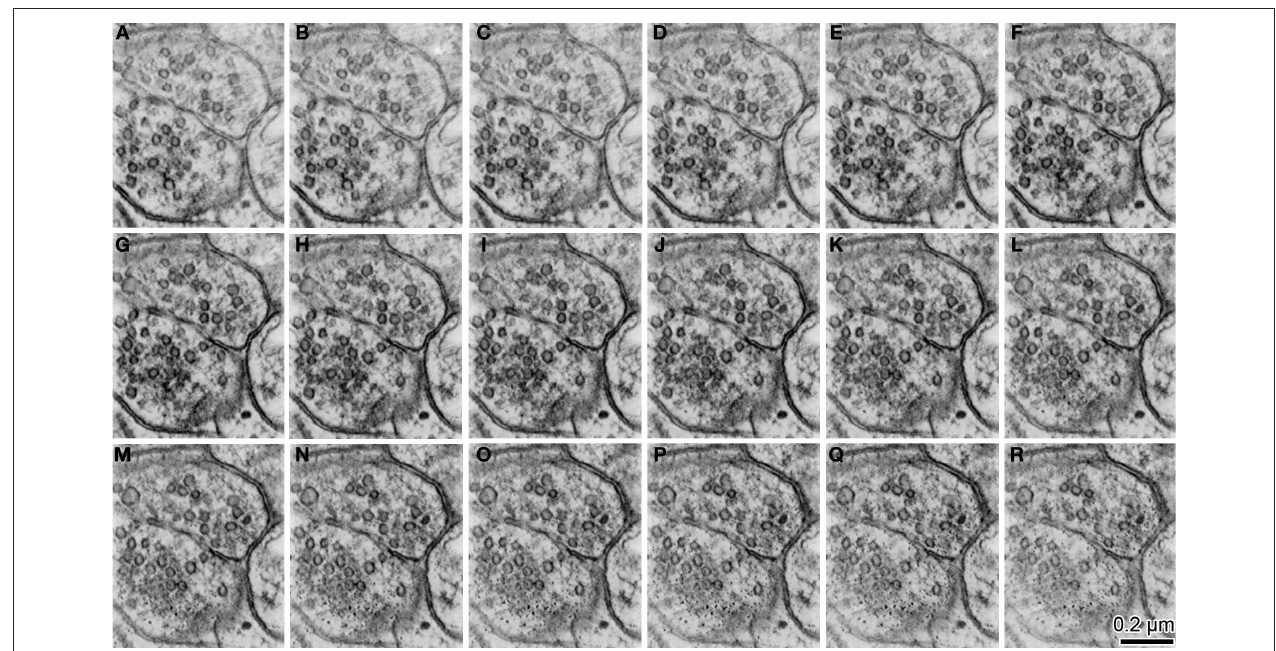
FIGURE 4 | The serial z-slice sections obtained by the tomography analysis showing the synaptic terminals shown in Figure 3K. We picked up 16 z-slice sections ( A–R ) of good quality from the middle of the